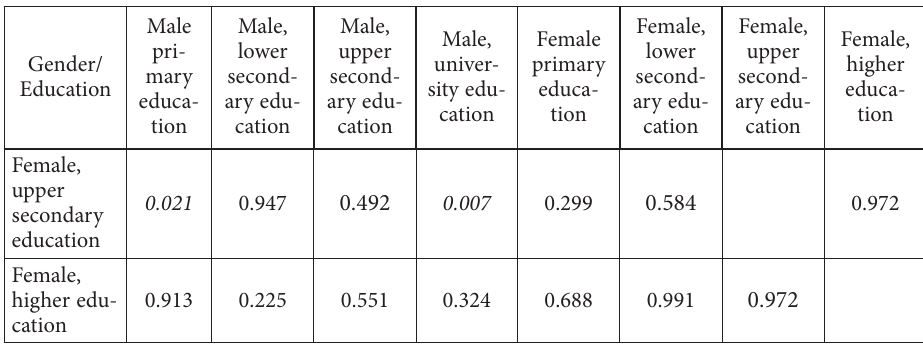
Table 8. Relative frequency for motivational factor good working team from the point of view of education Level of education